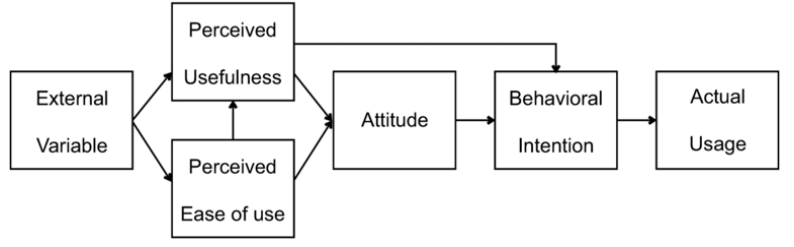
Fig. 2. TAM initial construct model